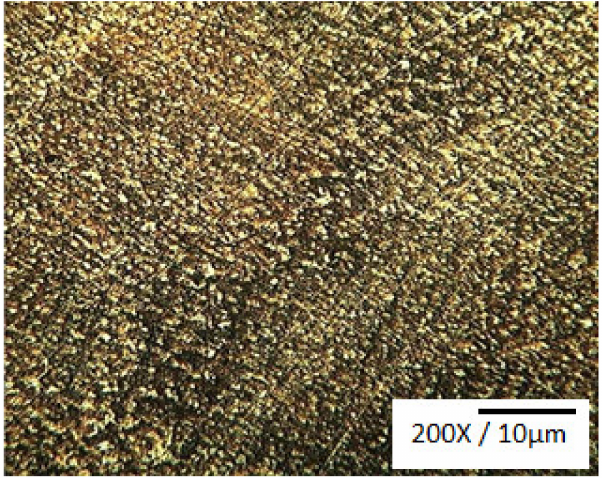
Figure 8. Modified structure of Cu-10Sn alloy